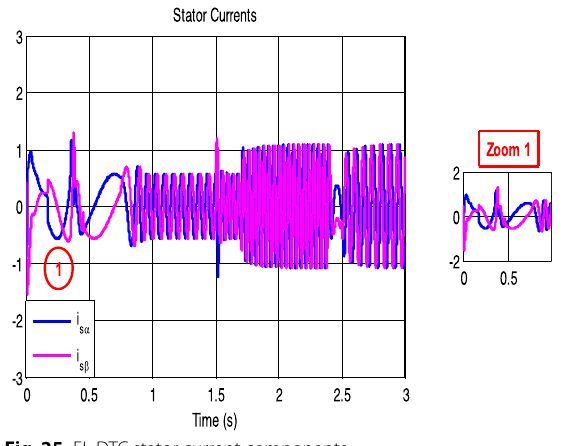
Fig. 25 FL-DTC stator current components